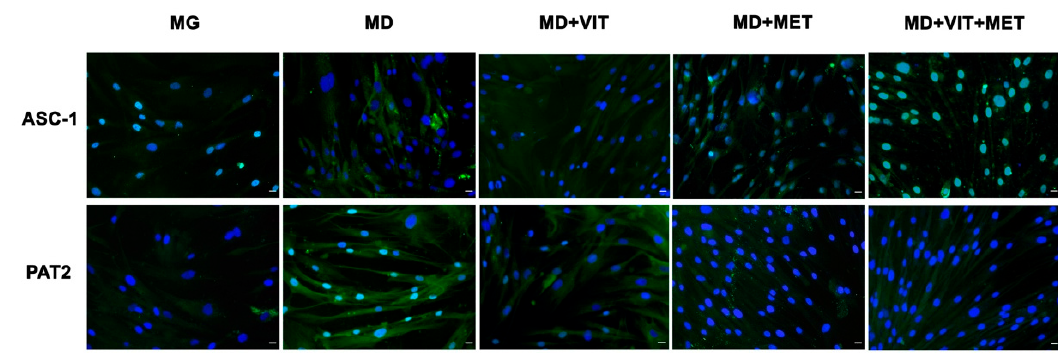
Figure 5. Analysis of adipogenic specific proteins after 21 days in culture. Immunohistochemical analysis of the expression of ASC-1 and PAT2 was assessed in ADSCs cultured in the basic growing medium (MG) or and in the differentiation medium (MD) or the differentiation medium plus vitamin D (MD+VIT) or metformin (MD+MET) or with both vitamin D and metformin (MD+VIT+MET). The figures are representative of different independent experiments. Nuclei are labelled with 4,6-diamidino-2-phenylindole (DAPI, blue). Scale bars: 40 µm.